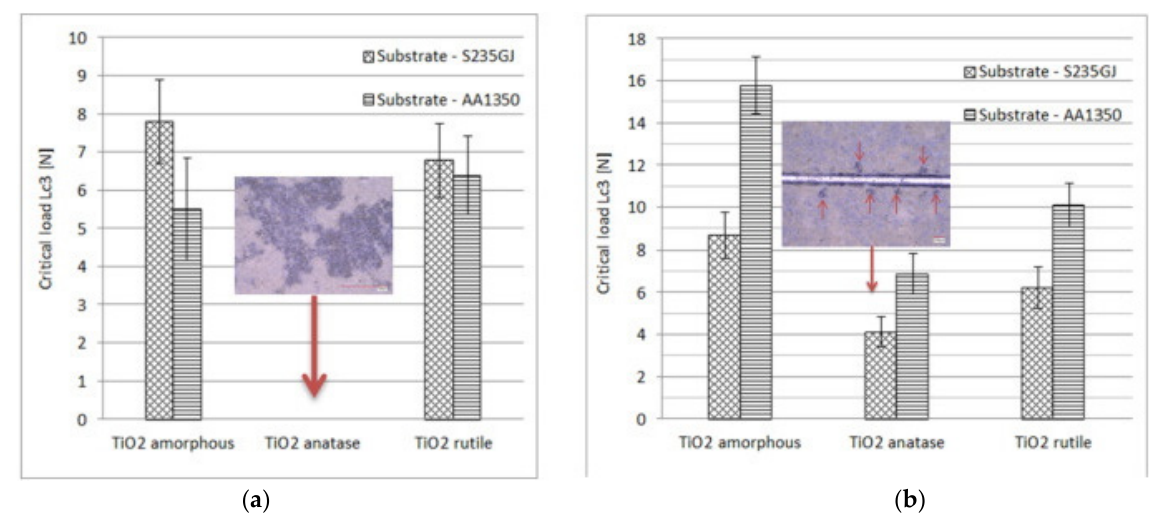
Figure 30. Critical load Lc 3 results obtained for coatings deposited onto the ground ( a ) and grit blasted substrate (alumina grain size of D 50 = 30 µm) ( b ) . Reprinted with permission from [251]. Copyright 2021 Elsevier.